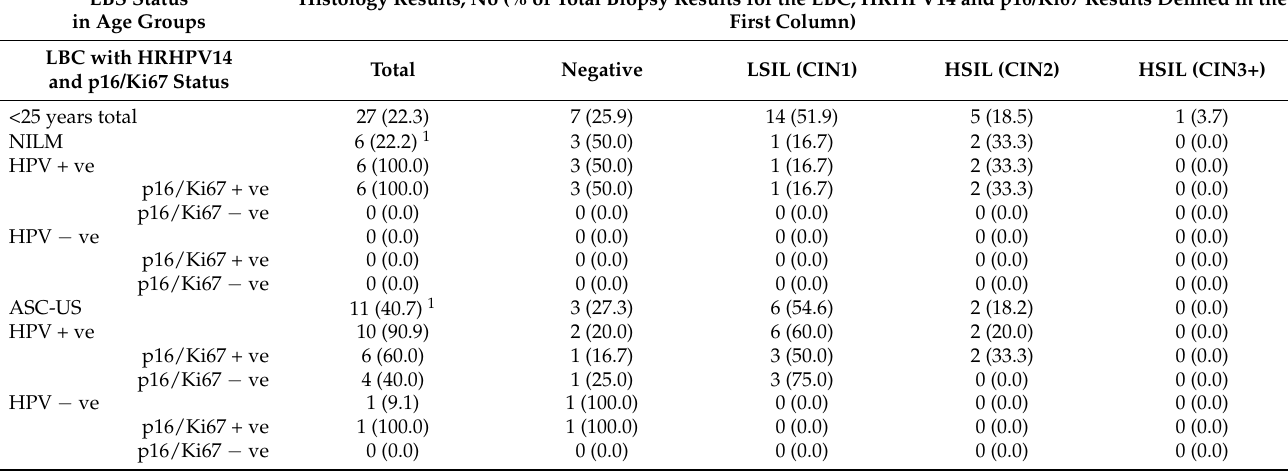
Table 10. Age-stratified biopsy results (<25, 25–29 and <30 years) biopsy results with preceding LBS results. LBS Status in Age